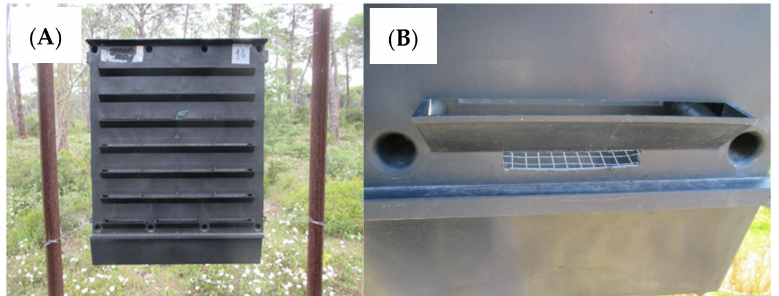
Figure 2. Standard trap without modifications ( A ) and detail of a modified trap ( B ): through one of the three escape windows the 6mm mesh screen can be seen